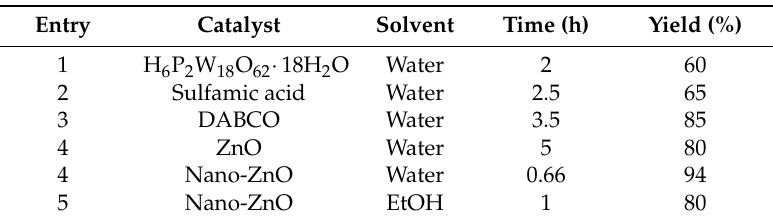
Table 1. Optimization of the reaction conditions for the synthesis of pyrazole based pyrido[2,3- d ] pyrimidine-diones under thermal conditions.